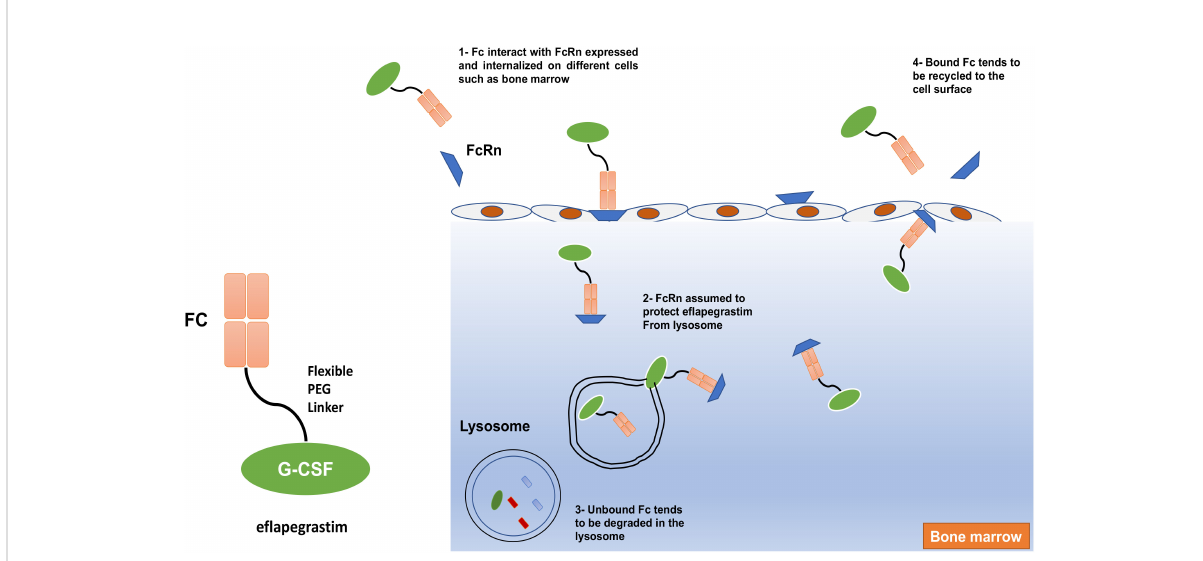
FIGURE 7 The mechanism of action of e fl apegrastim. The human IgG4 Fc fragment of E fl apegrastim interacts with FcRn, which is expressed and internalized on different cells such as bone marrow and assumed to protect e fl apegrastim from lysosome leads to elongate its retention in bone